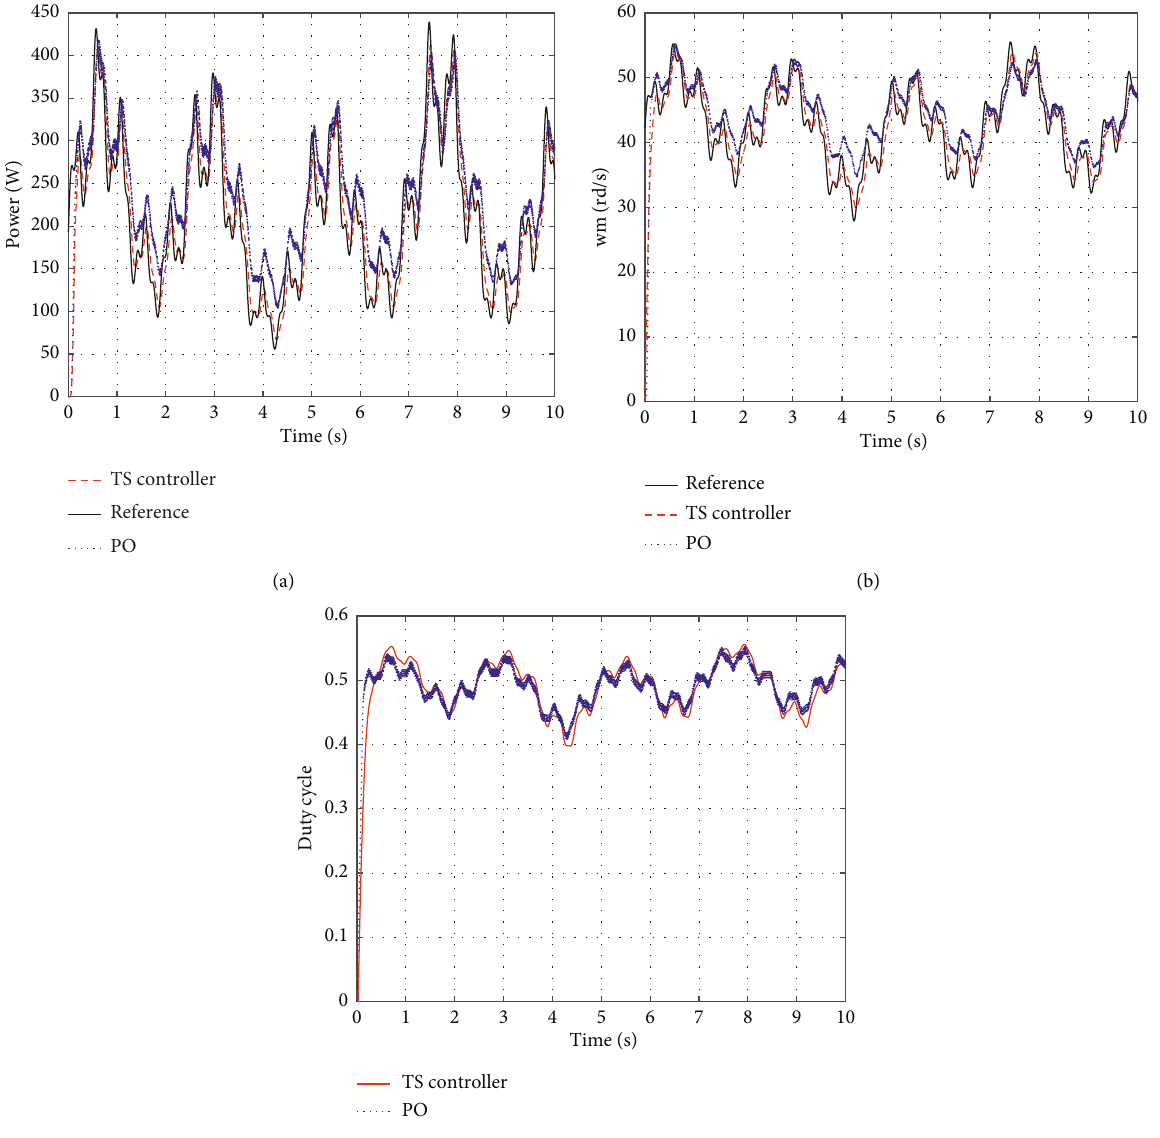
Figure 6: Time evolution of (a) output power, (b) rotor speed, and (c) control signal.